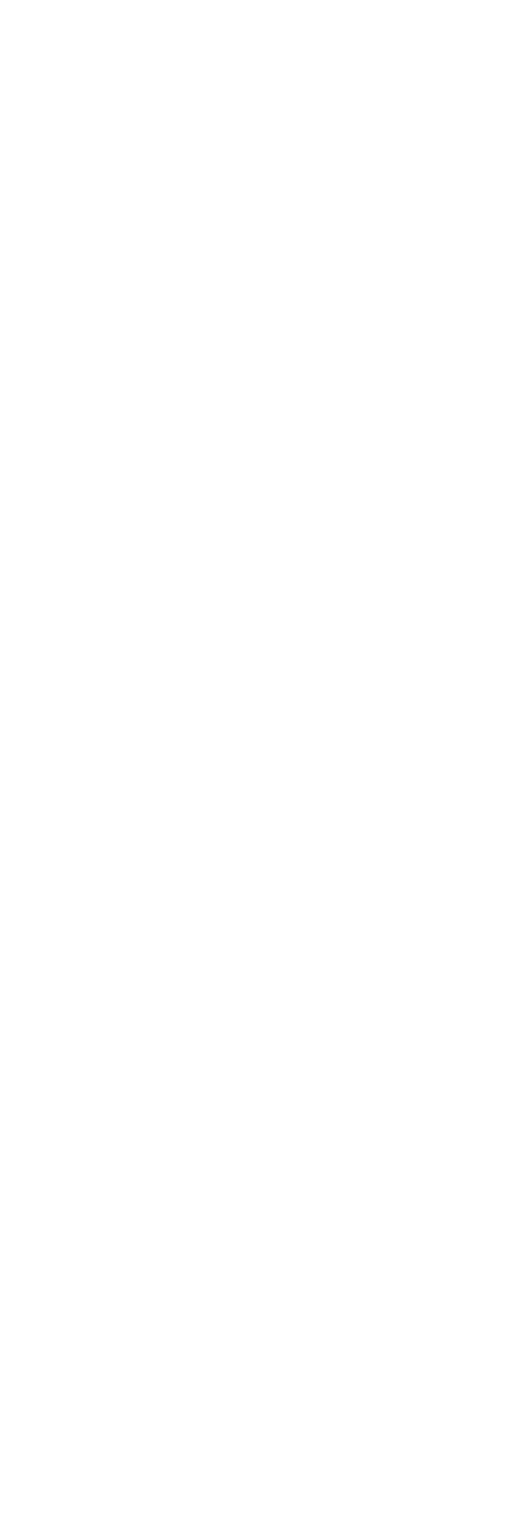
Table A1 | Abbreviations for the regions in the